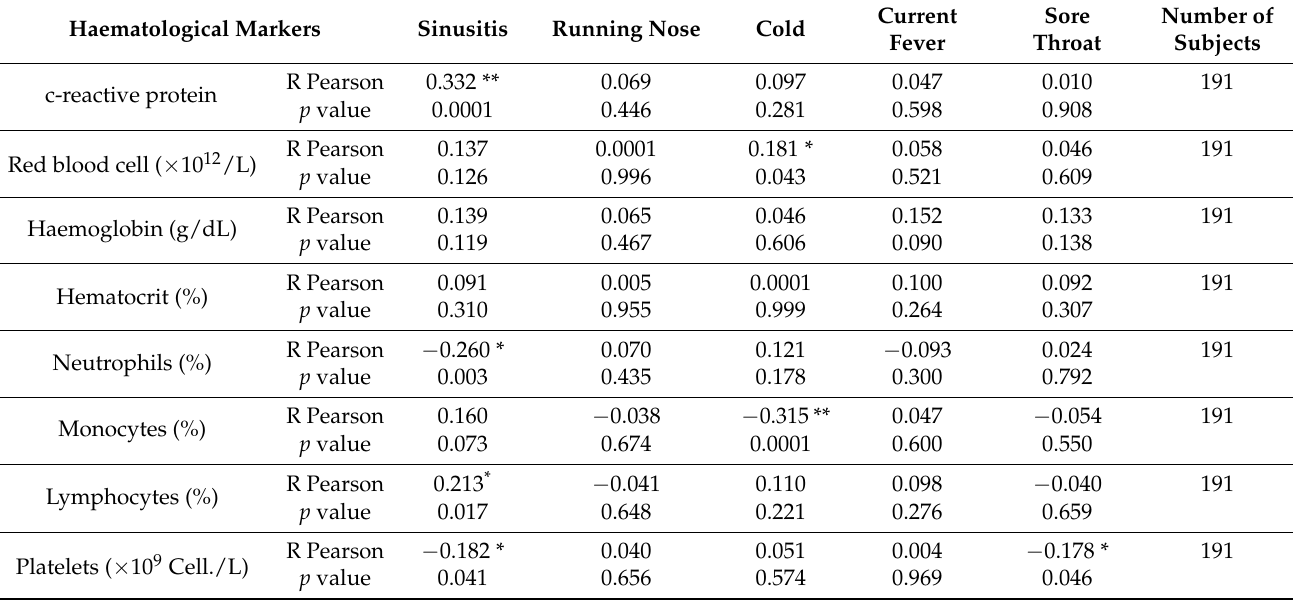
Table 8. Correlation between symptoms of upper airways and changes of haematological